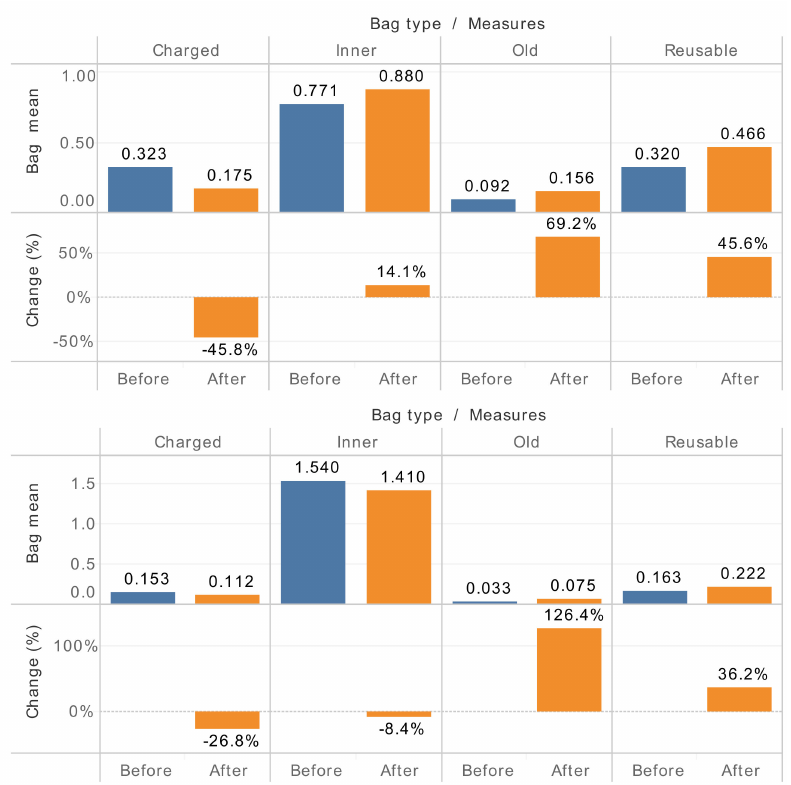
Figure 1. Comparative bag usage of non-grocery markets with (upper) and without (lower) tougher measures. Table 2. The mean values, before/after usage changes, and KW test results for the usage of different types of bags between different packaging styles before and after tougher measures. Packaging